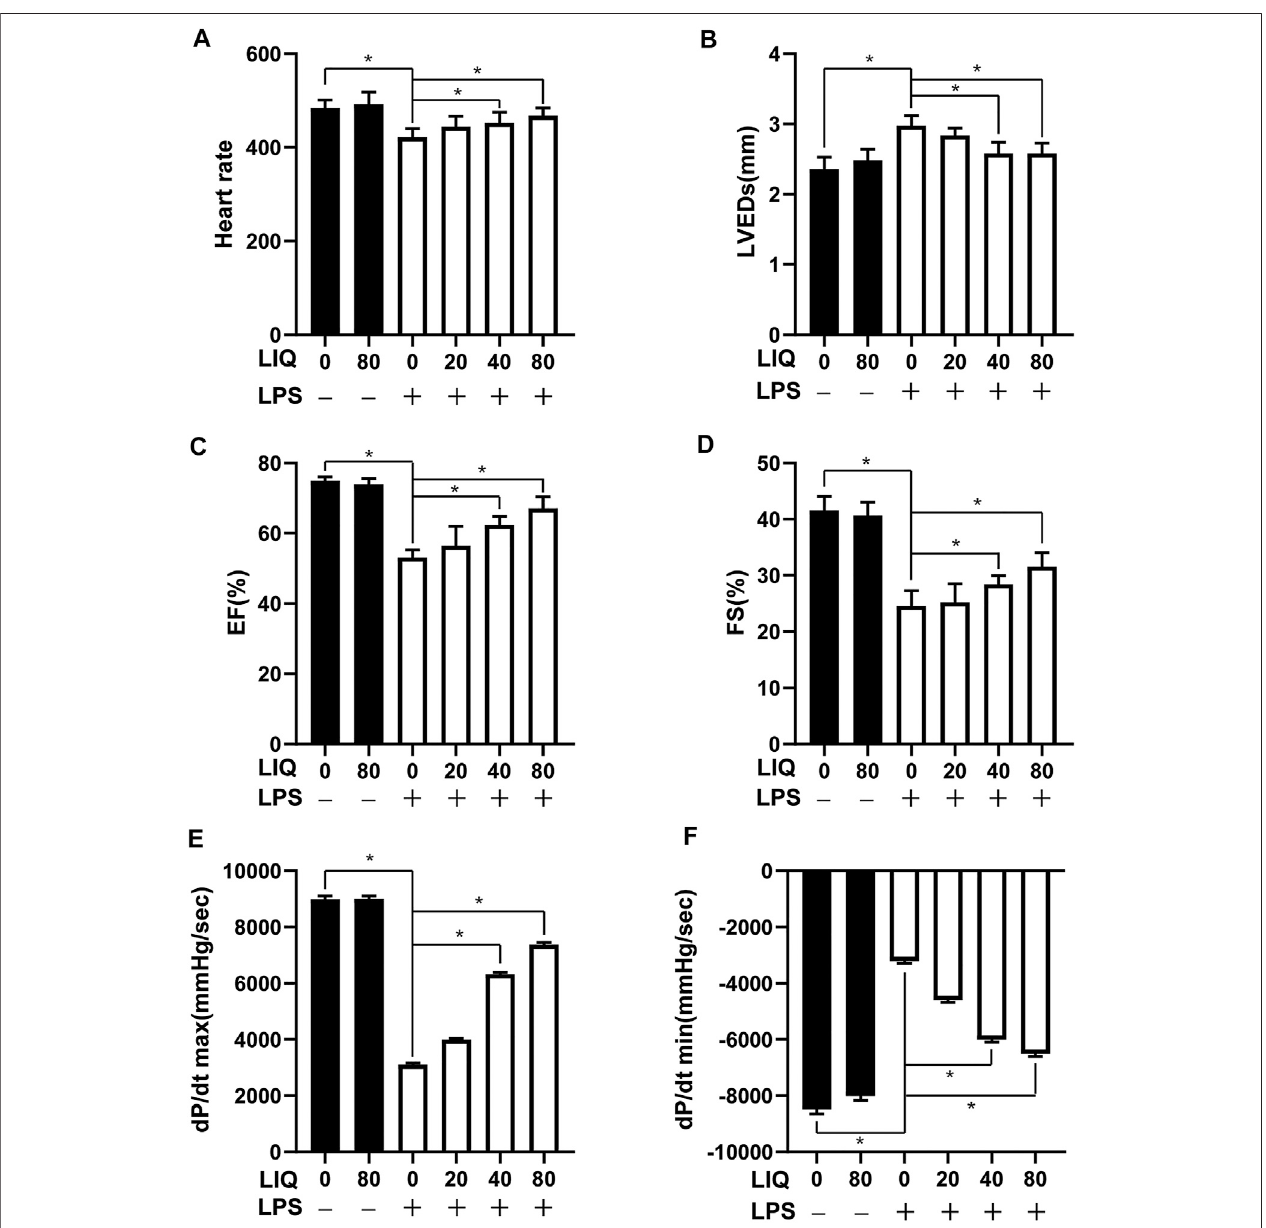
FIGURE 1 | LIQ treatment attenuated LPS-induced mouse cardiac dysfunction Echocardiography and pressure-volume loop was performed to analyze mouse cardiac function after treatment with LPS (10 mg/kg) or saline for 12 hours, (A) heart rate (HR), (B) left ventricular end-systolic diameter (LVEDs), (C) left ventricular ejection fraction (EF), (D) left ventricular fractional shortening (FS), (E) maximal rate of pressure development (dp/dt max), (F) minimal rate of pressure decay (dp/dt min), ( n (cid:2) 10). The data were expressed as the Mean ± SEM. p p < 0.05 compared with the indicated group. The data were compared by one-way ANOVA with Tukey post hoc